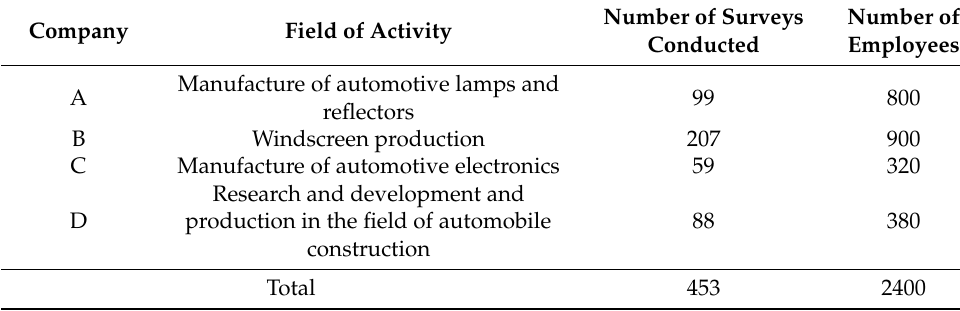
Table 1. Information about the companies in which the survey was conducted.